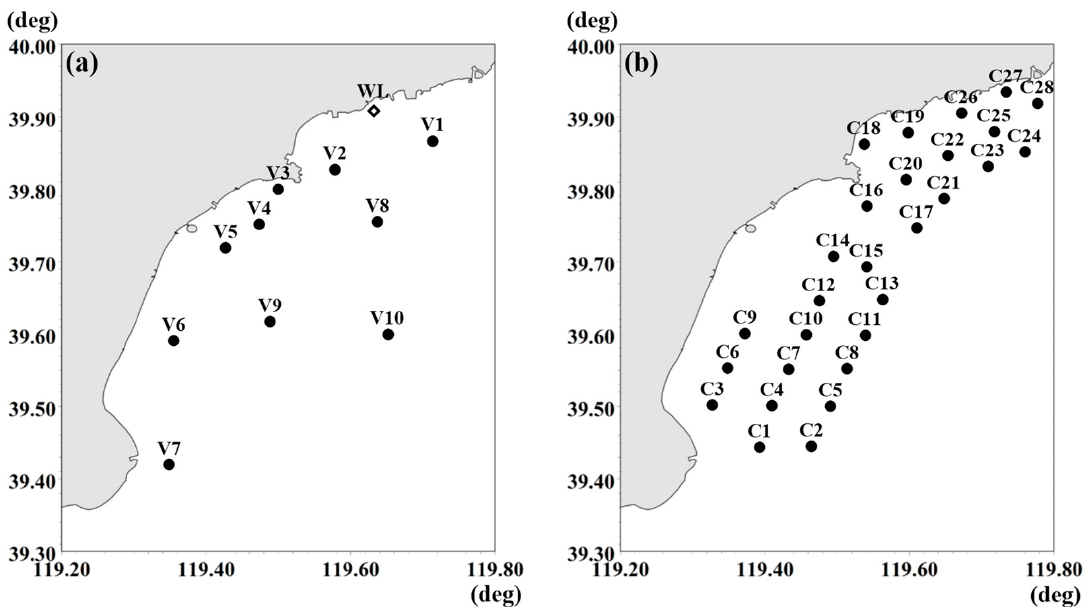
Figure 2. ( a ) Locations of field observation stations V1 to V10 for velocity and WL for water level; ( b ) locations of 28 chemical oxygen demand (COD) sampling stations.